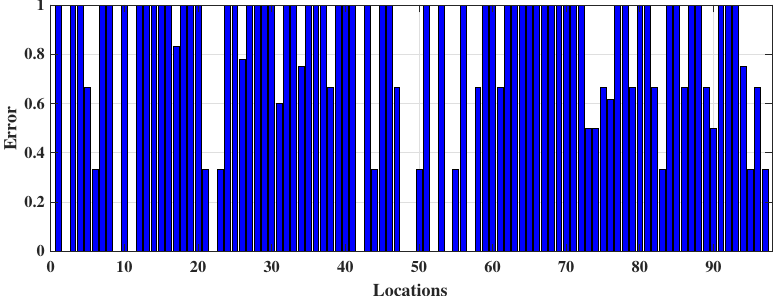
Figure 7. The occurrence of error in each coordinate from 3 NN Eu classification during online